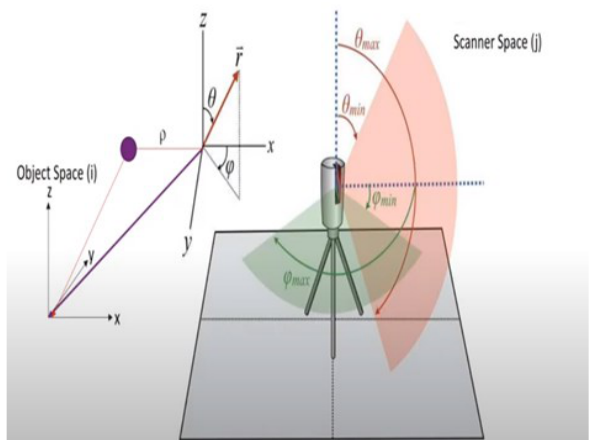
Figure 5(b). The working principle of Phase-based measurement.